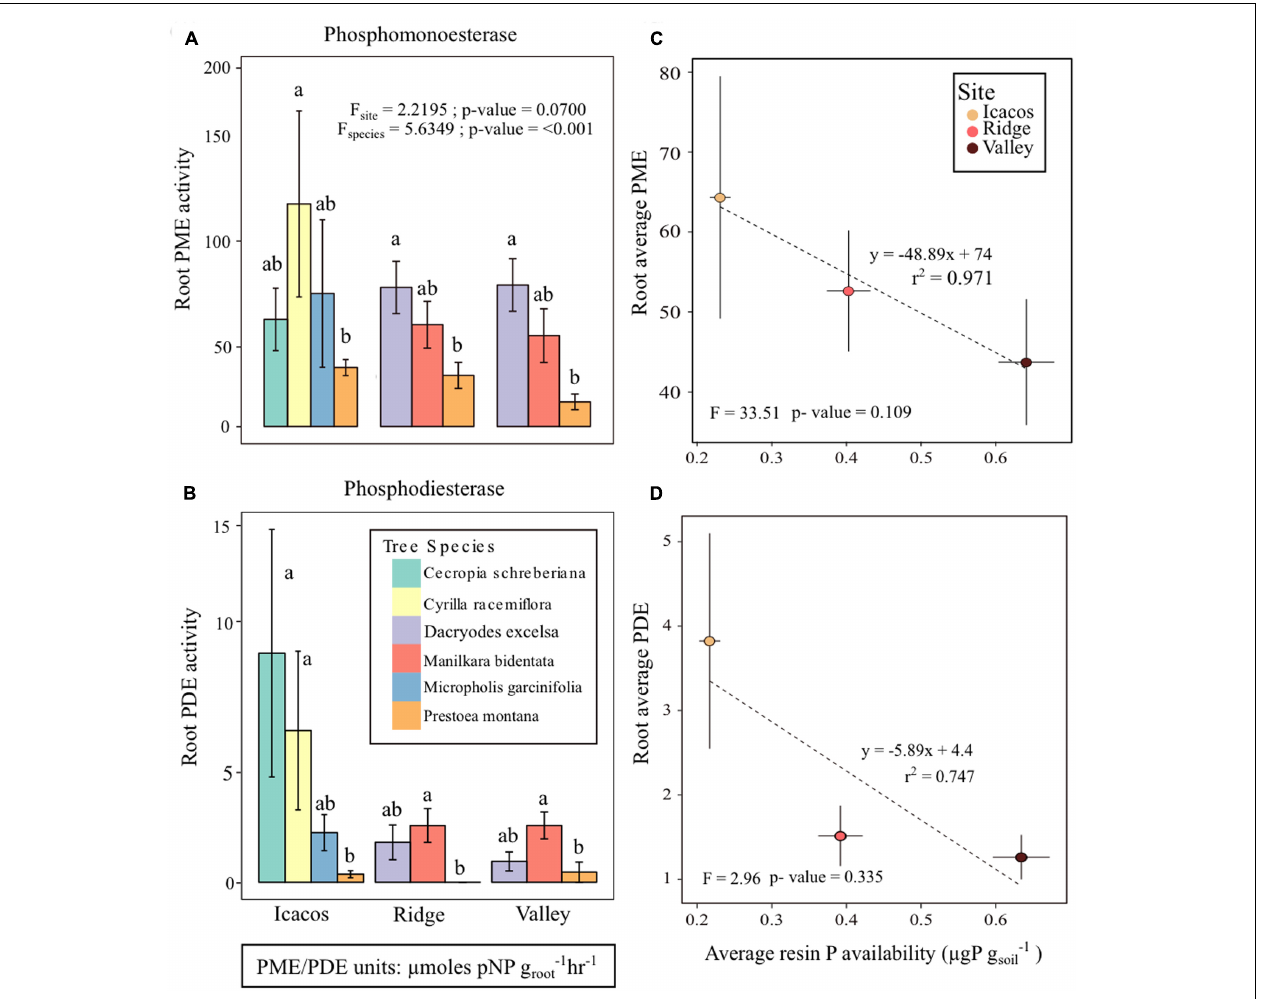
FIGURE 2 | (A) Root phosphomonoesterase (PME) activity, (B) root phosphodiesterase (PDE) activity, (C) average root PME activity plotted with average resin P availability at each site, and (D) average root PDE activity with average resin P availability. Letters represent differences in group means among tree species and error bars are mean ± SE with n = 3 individual trees per species at each